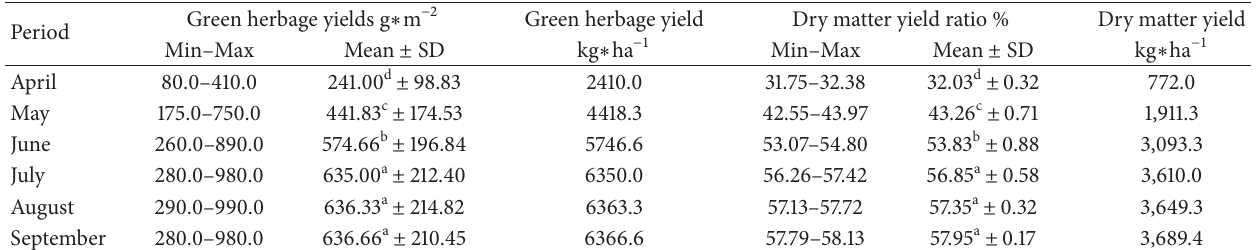
Table 2: Green herbage yield, dry matter ratio, and dry matter yield